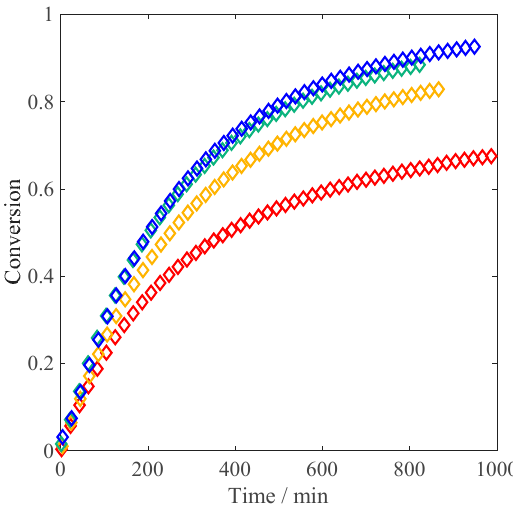
Figure 4. Monomer conversion versus time profiles of the radical batch polymerization of fully ionized MAA in aqueous solution at 50 ◦ C, 0.1 wt % of V-50 initiator, and initial monomer concentration equal to 1 wt % (red), 2.5 wt % (yellow), 5 wt % (green), and 10 wt % (blue).